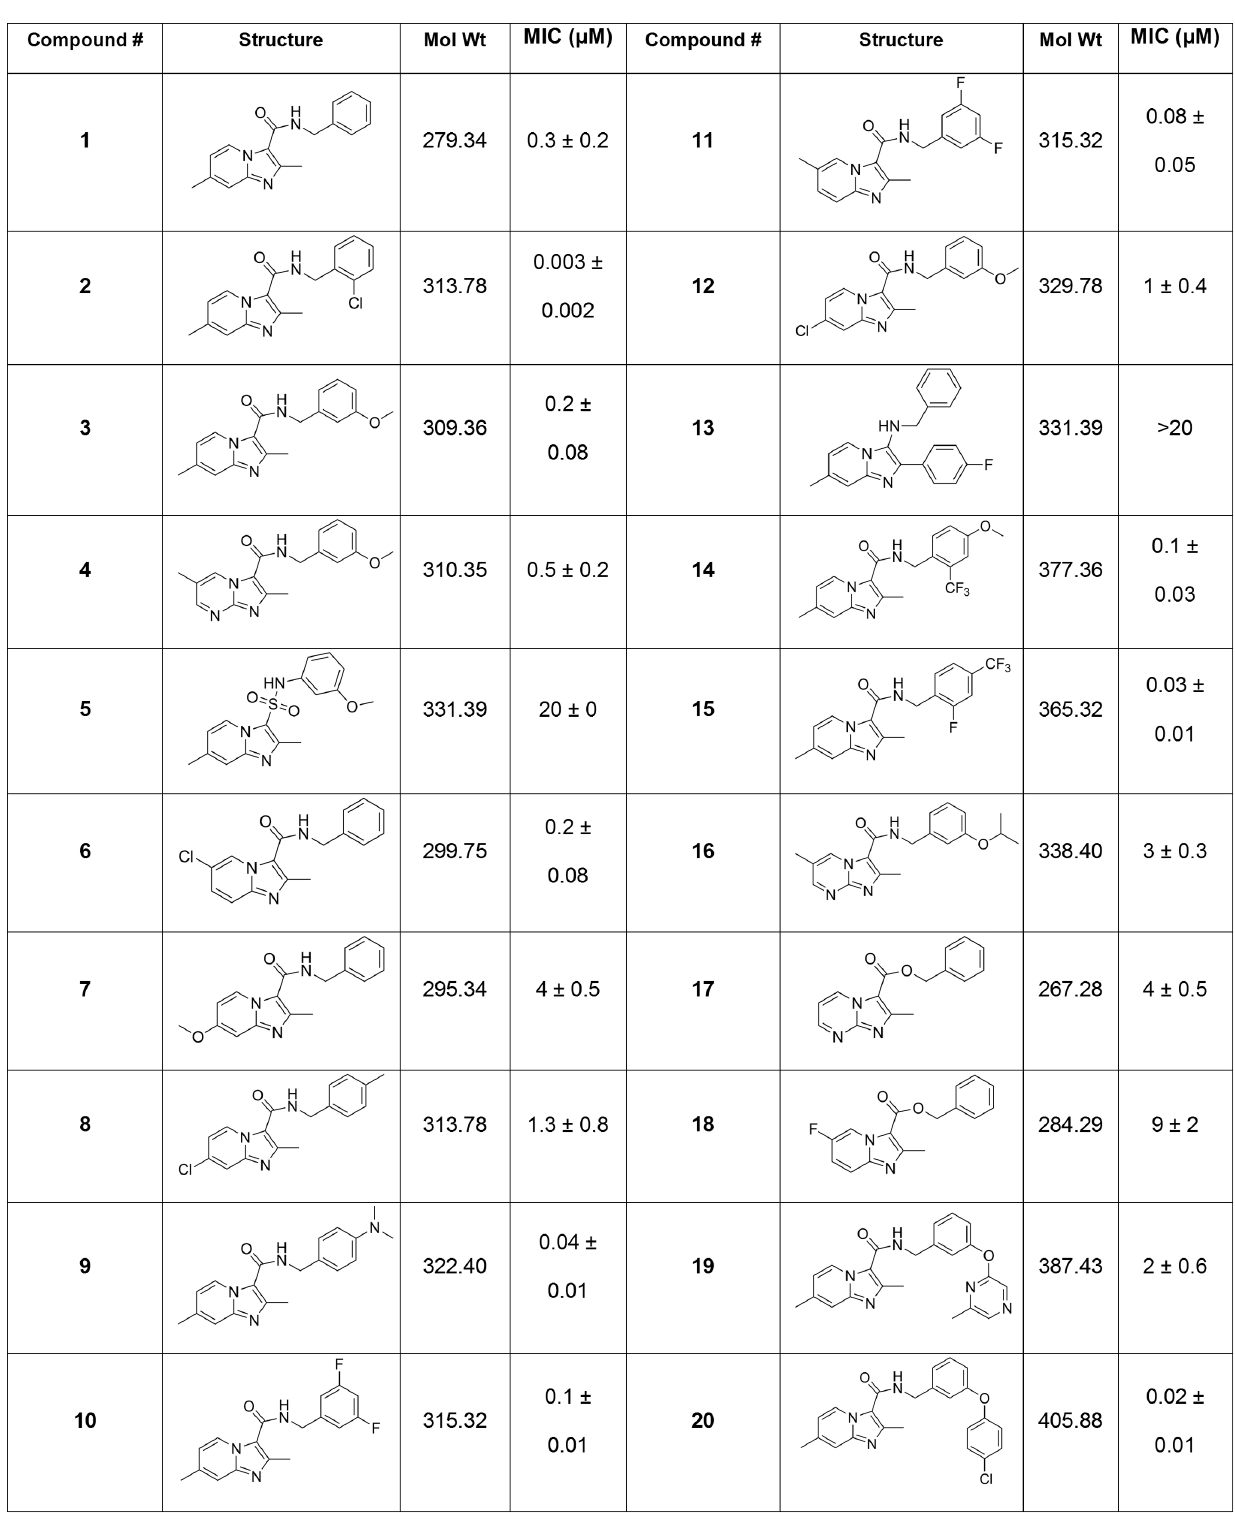
Figure 6. MIC determination of imidazo[1,2-a]pyridine compounds. MICs were determined in liquid medium using two readouts of growth (OD and fluorescence). The values from both readouts were combined and results are the average and standard deviations for a minimum of two independent runs.